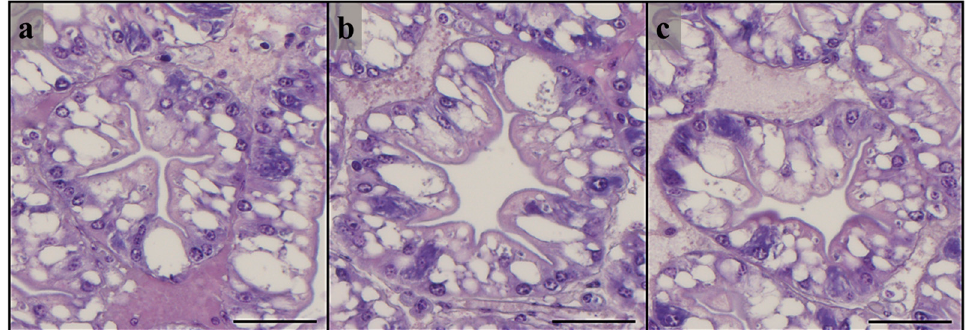
Figure 1. ( a ) Schematic representation of transversal section of hepatopancreas tubule from high- lighting a detailed example of R cell and B cell (author: Matteo Zarantoniello). ( b ) Example of his- tomorphology of transversal section of a hepatopancreas tubule (middle portion) from HM0 group.